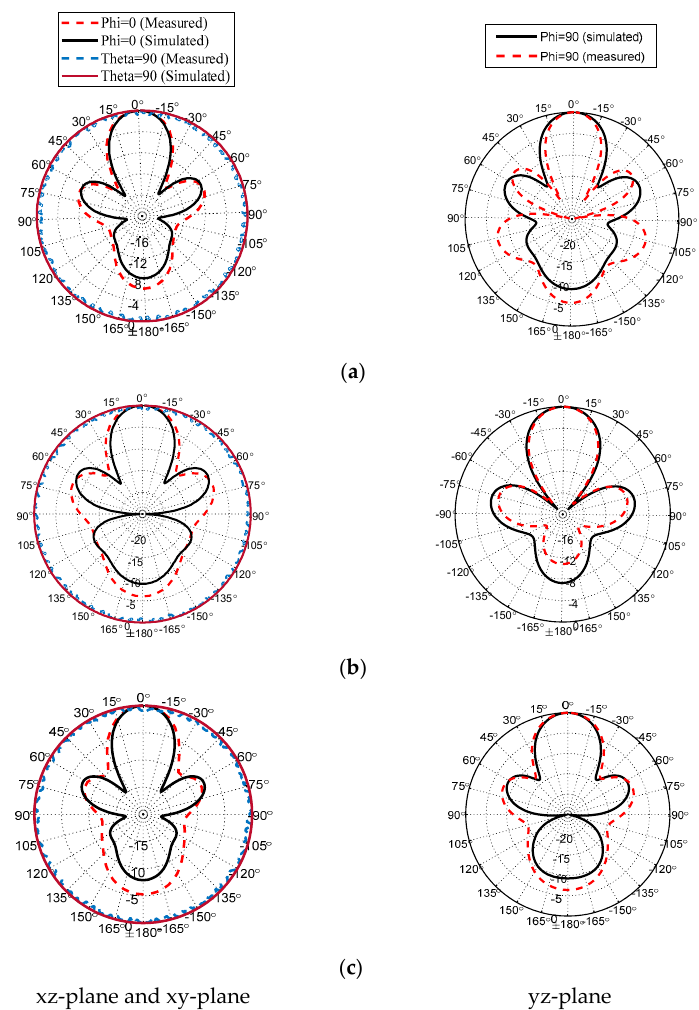
Figure 15. Antenna radiation patterns. ( a ) At 28.5 GHz . ( b ) At 29.5 GHz. ( c ) At 30.5 GHz.